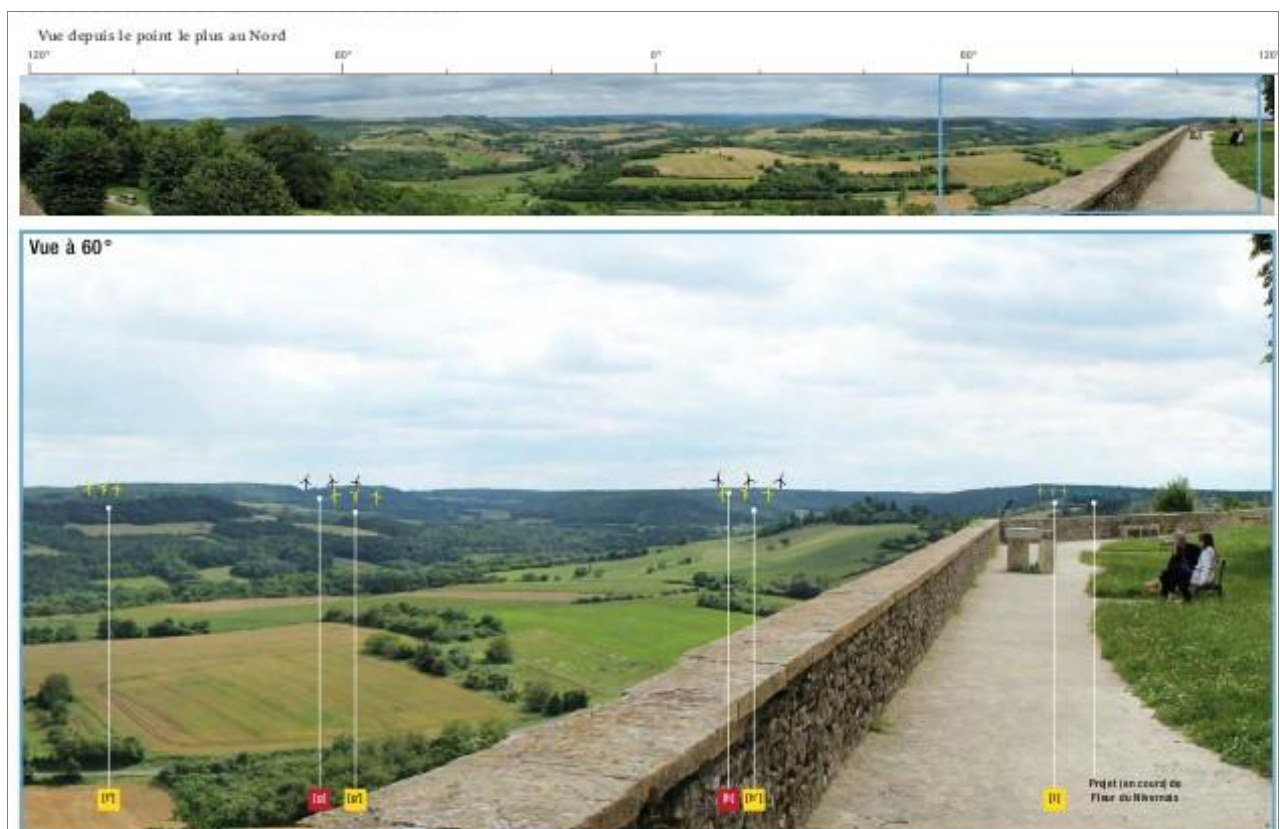
Figure 16. Positive example of the depiction of an outgoing view with panorama baseline on top and the view section with graphic accentuation, color code, and reference to evaluation scheme in Vézelay (France) (Source: [84]).